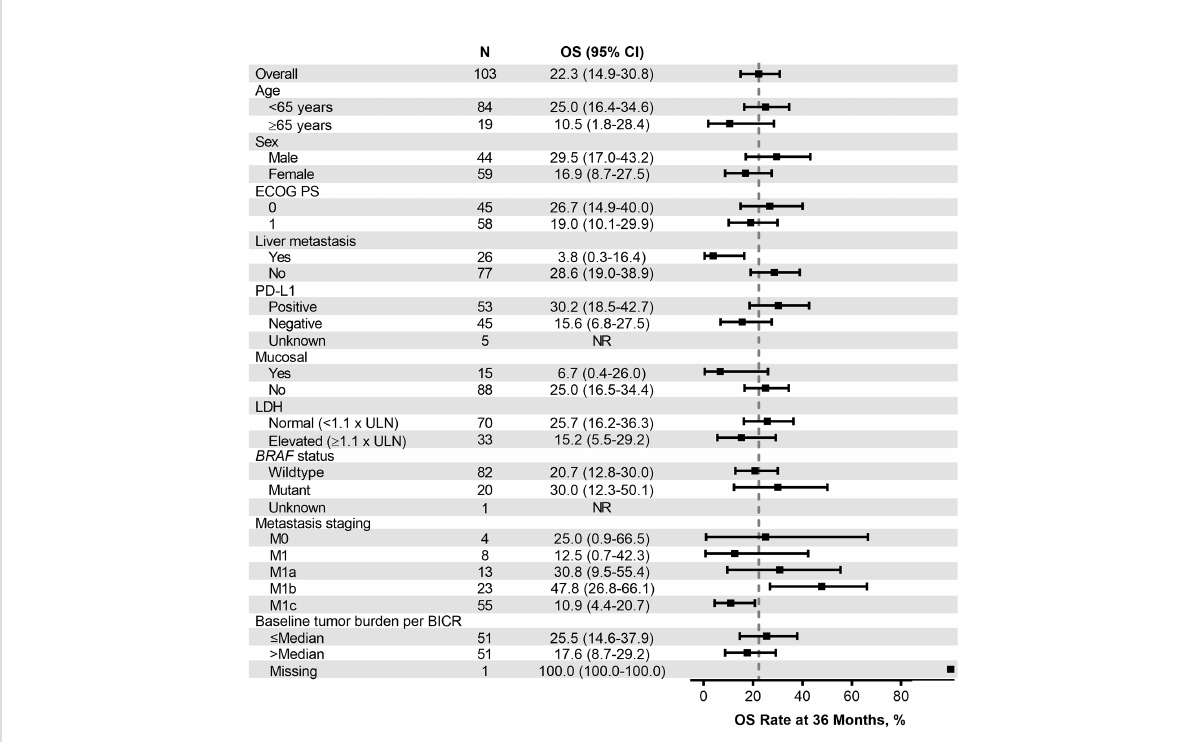
FIGURE 5 Forest plot of OS rate at 36 months in patient subgroups by baseline characteristics (ASaT population). ASaT, all subjects as treated; BICR, blinded independent central review; ECOG PS, Eastern Cooperative Oncology Group performance status; LDH, lactate dehydrogenase; OS, overall survival; PD-L1, programmed death ligand 1; ULN, upper limit of